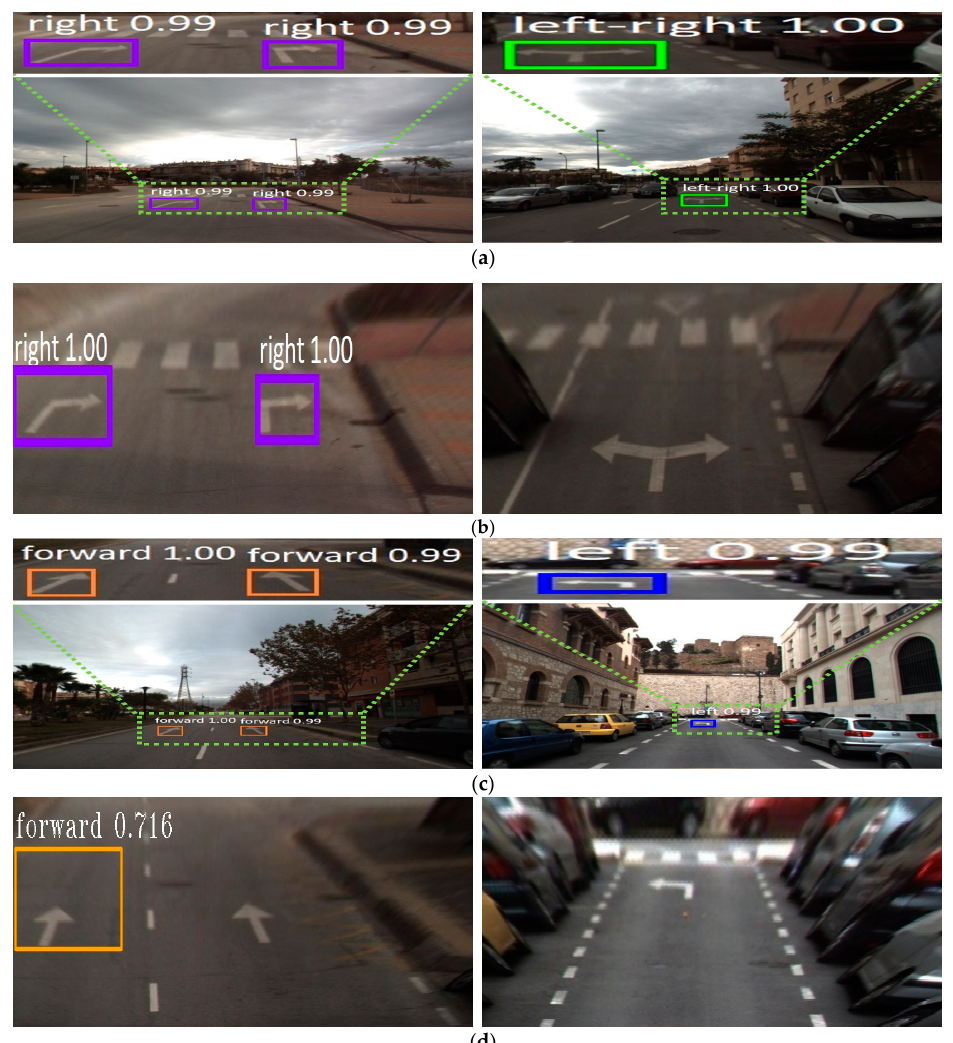
Figure 15. Examples of detection results by the original or IPM images. Result by ( a ) original image, and that by ( b ) IPM image of ( a ). Result by ( c ) original image, and that by ( d ) IPM image of ( c ).